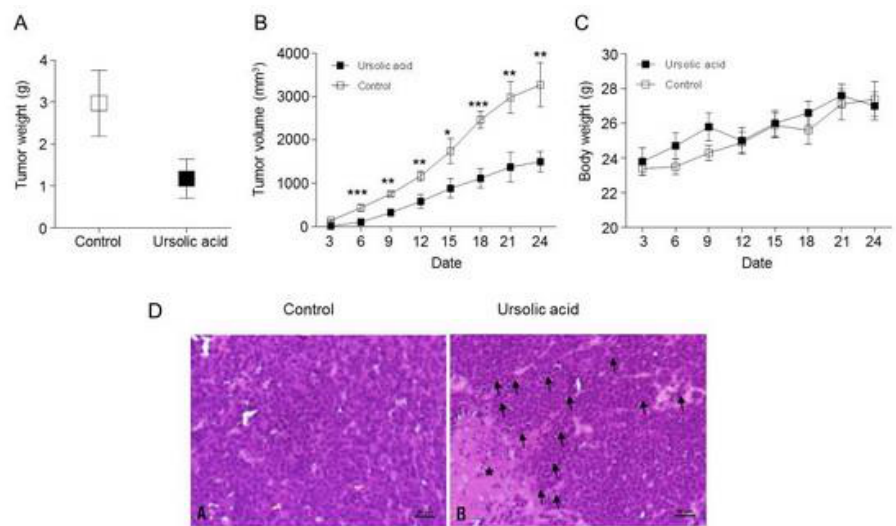
Figure 8. E ff ects of UA on gastric tumor growth. UA inhibits the growth of gastric tumors of xenograft mice and results are shown for vehicle-treated control and UA-treated group. ( A ) tumor weights were measured after finish of therapy. * p < 0.05 when compared to the control. ( B ) Tumor volume was measured by a caliper in three times per week and calculated as (width) 2 × length / 2. (UA, ursolic acid), * p < 0.05, ** p < 0.01, and *** p < 0.001 compared with the control at each time point. ( C ) Animal body weights were measured during the course of the experiments. ( D ) E ff ect of UA on histological tumor tissue. Control group; round to oval hyperchromatic nuclei with scant cytoplasm. UA group; Minimal or mild necrosis (*) but lymphocyte infiltration (black arrows) around tumor cells. hematoxylin and eosin (H&E), bar = 50 μM.